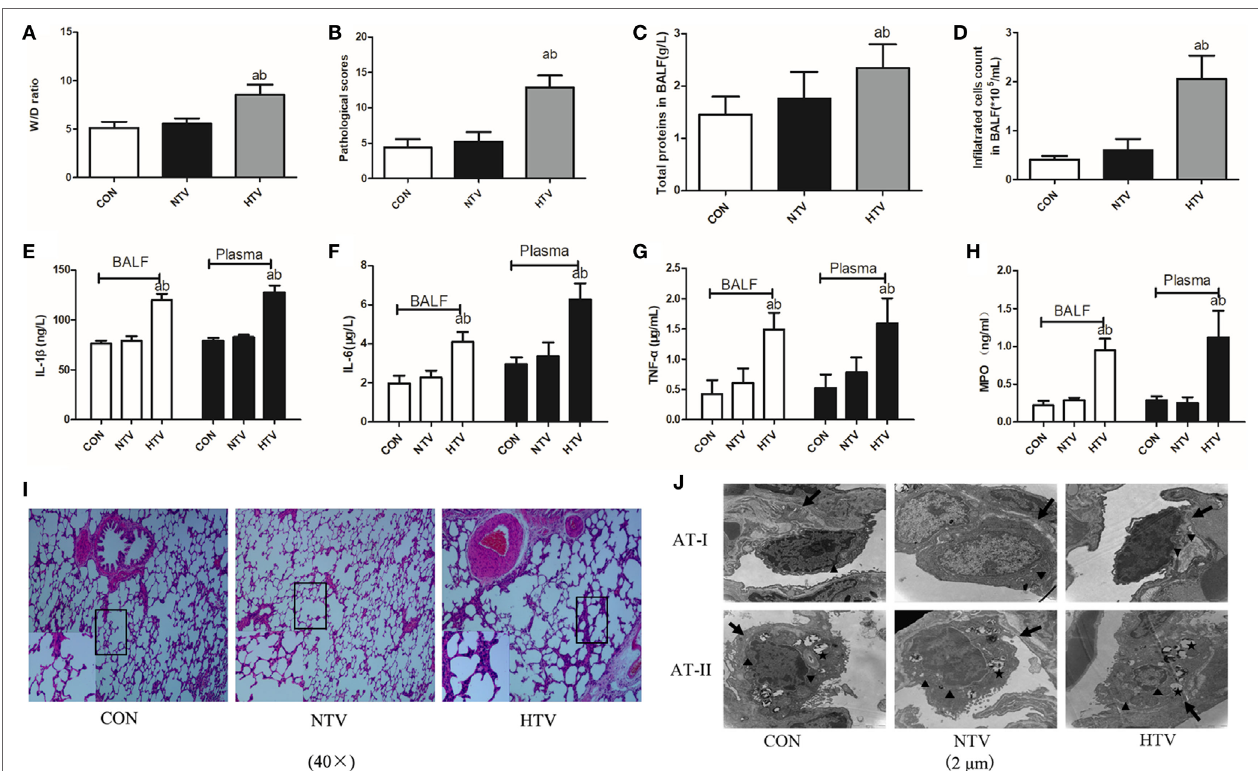
FigUre 1 | Lung injury and inflammation in animals with spontaneous breathing (CON) or mechanical ventilation at normal tidal volume (NTV) or high tidal volume (HTV). (a) Lung edema was assessed by determining the weight ratio between wet and dry lung (W/D). (B) Pathological scores were assessed by results of hematoxylin and eosin (HE) staining. (c) Total protein concentration in bronchoalveolar lavage fluid (BALF). (D) Infiltrated cell counts in BALF. (e) Levels of interleukin (IL)-1 β in BALF and plasma. (F) Levels of IL-6 in BALF and plasma. (g) Levels of tumor necrosis factor (TNF)- α in BALF and plasma. (h) Levels of myeloperoxidase (MPO) in BALF and plasma. (i) Histology of lung tissue was stained with HE. Magnification, 40 × . (J) Transmission electron micrographs of alveolar cells. Areas marked with arrows signify continuous membrane and triangles mark areas of disrupted cytoplasmic and nuclear structure. Areas marked with stars represent the osmilphilic multilamellar bodies, the unique structure of AT-IIs. Tissue from CON and NTV groups appeared normal, but tissue from HTV group exhibited a disrupted cytoplasmic and nuclear structure, as well as cell membrane discontinuities. In addition, the osmilphilic multilamellar bodies show characteristic vacuolation in the HTV group. Magnification, 20,000 × . Both of these experiments were in triplicate. a P < 0.05 vs. CON group; b P < 0.05 vs. NTV